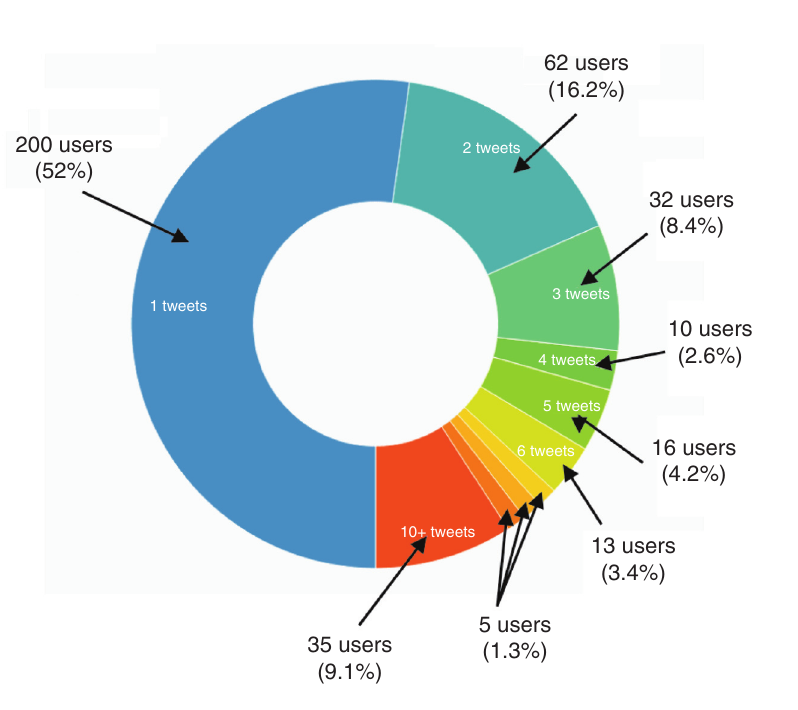
Figure 3. Illustration of the number of tweets sent by individuals; blue = 1 tweet; red = 10+ tweets. Reproduced from data reports obtained from the website